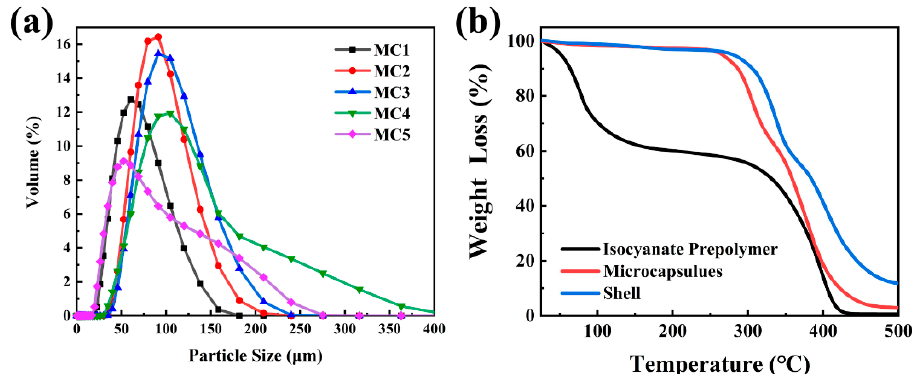
Figure 6. ( a ) Particle size distribution of microcapsules. ( b ) TGA curves of isocyanate prepolymer, microcapsules and shell. microcapsules and